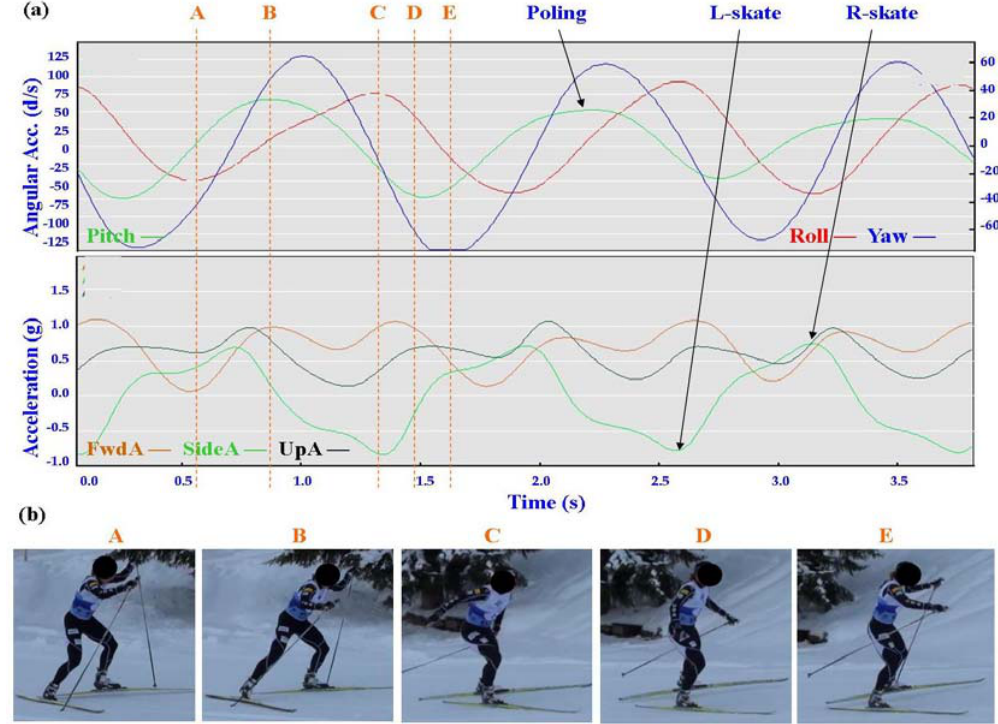
Figure 6. ( a ) Screenshot of Offset Skate (G2) gyroscope and accelerometer traces against time; ( b ) G2 body position for selection points.